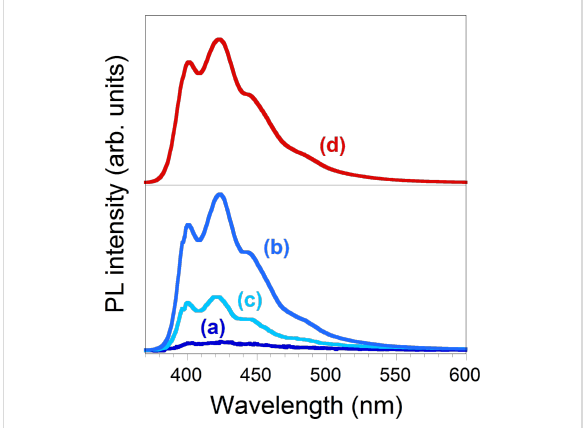
Figure 3: The fluorescence spectra of PT5 (a), PT15 (b), PT30 (c) and TF films